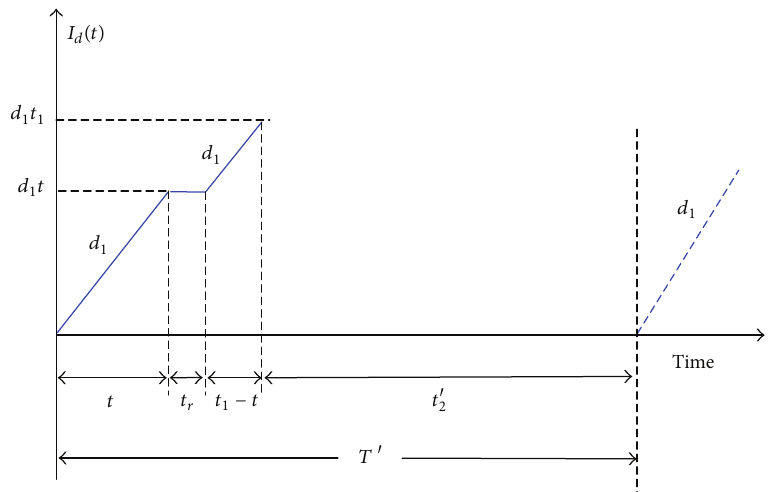
Figure 2: Inventory level of scrap items in the proposed manufacturing run time